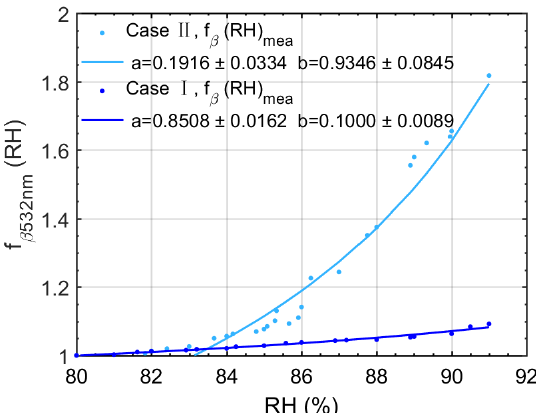
Figure 6. f β ( RH ) at 532nm retrieved on 21 May 2016 in the 1642.5–1905.0m layer (Case I, dark blue points) and 23 May 2016 in the 1680.0–2130.0m layer (Case II, light blue points). The best- fit lines through the points are shown. The reference RH is 80%.